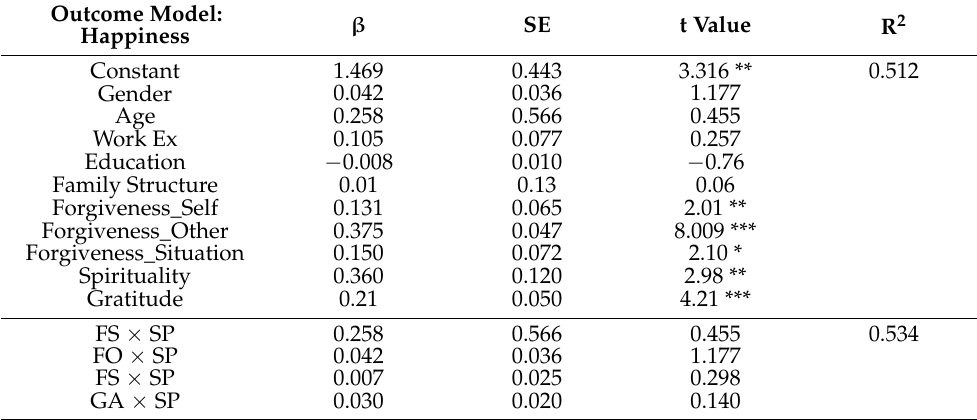
Table 3. PROCESS results for moderation at time 1.